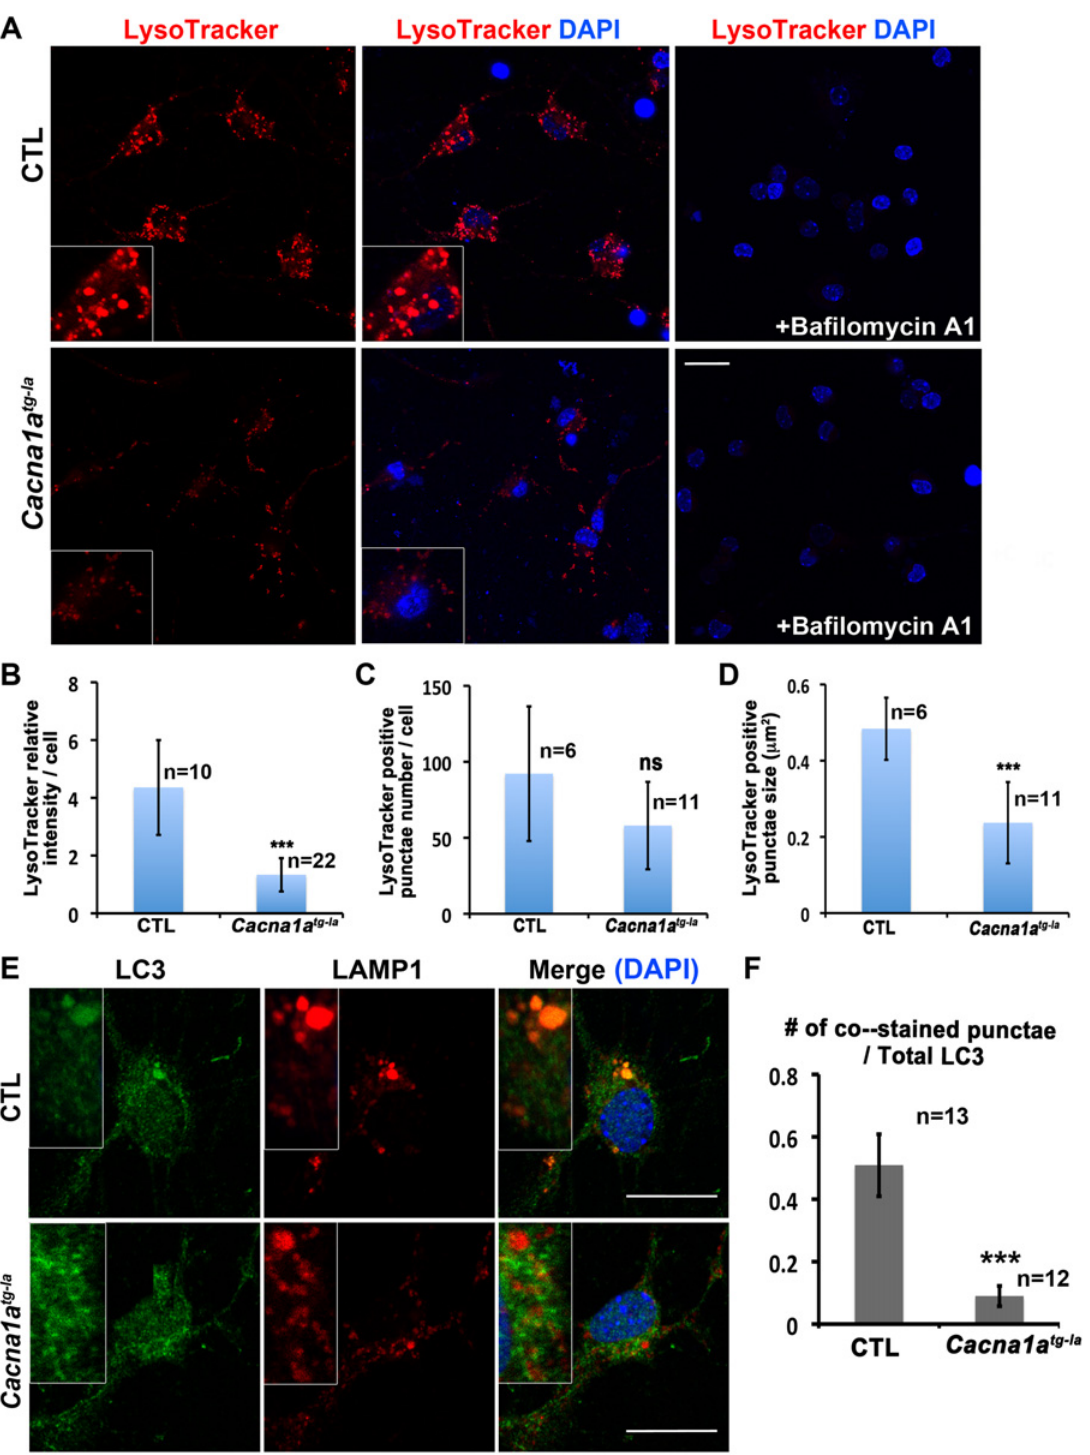
Fig 6. Cacna1a mutant neurons display lysosomal fusion defects. A. LysoTracker Red staining of the primary cerebella neurons from Cacna1a tg-la mice and WT controls. The control cells show big bright punctae, while the mutant cells have much dimmer and smaller punctae. B, C and D. Quantification of LysoTracker relative intensity ( “ n ” represents the counted cell number), LysoTracker positive punctae number and size per cell ( “ n ” represents the counted image number). E. Lysosomal marker LAMP1 co-localizes with autophagosome marker LC3 in CTL but not Cacna1a tg-la mutant cells. Scale bar, 20 μ m. F. Quantification of LC3 and LAMP1 co-localization. Data are presented as means ± SD. (ns: not significant; *** : p < 0.001).